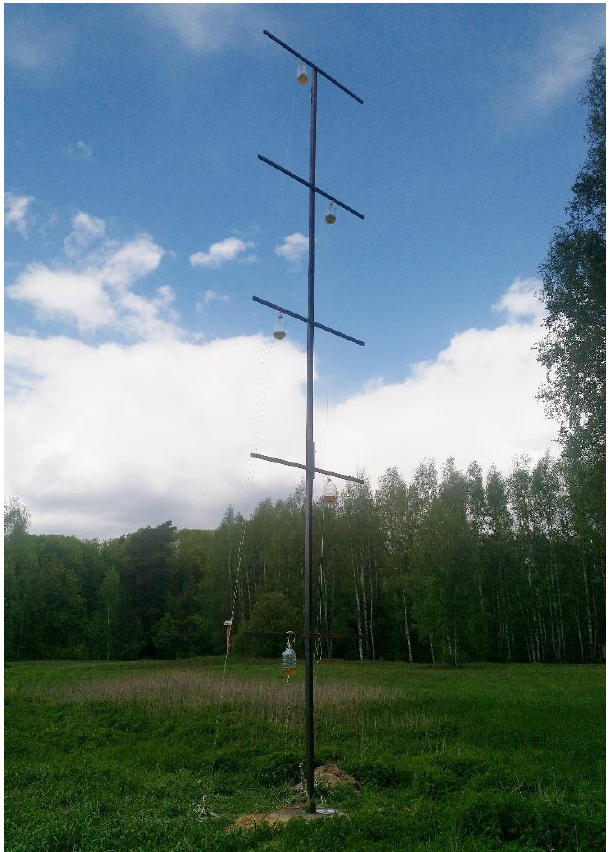
Figure 1. A special installation for conducting research on the territory of the Mordovia State Nature Reserve.